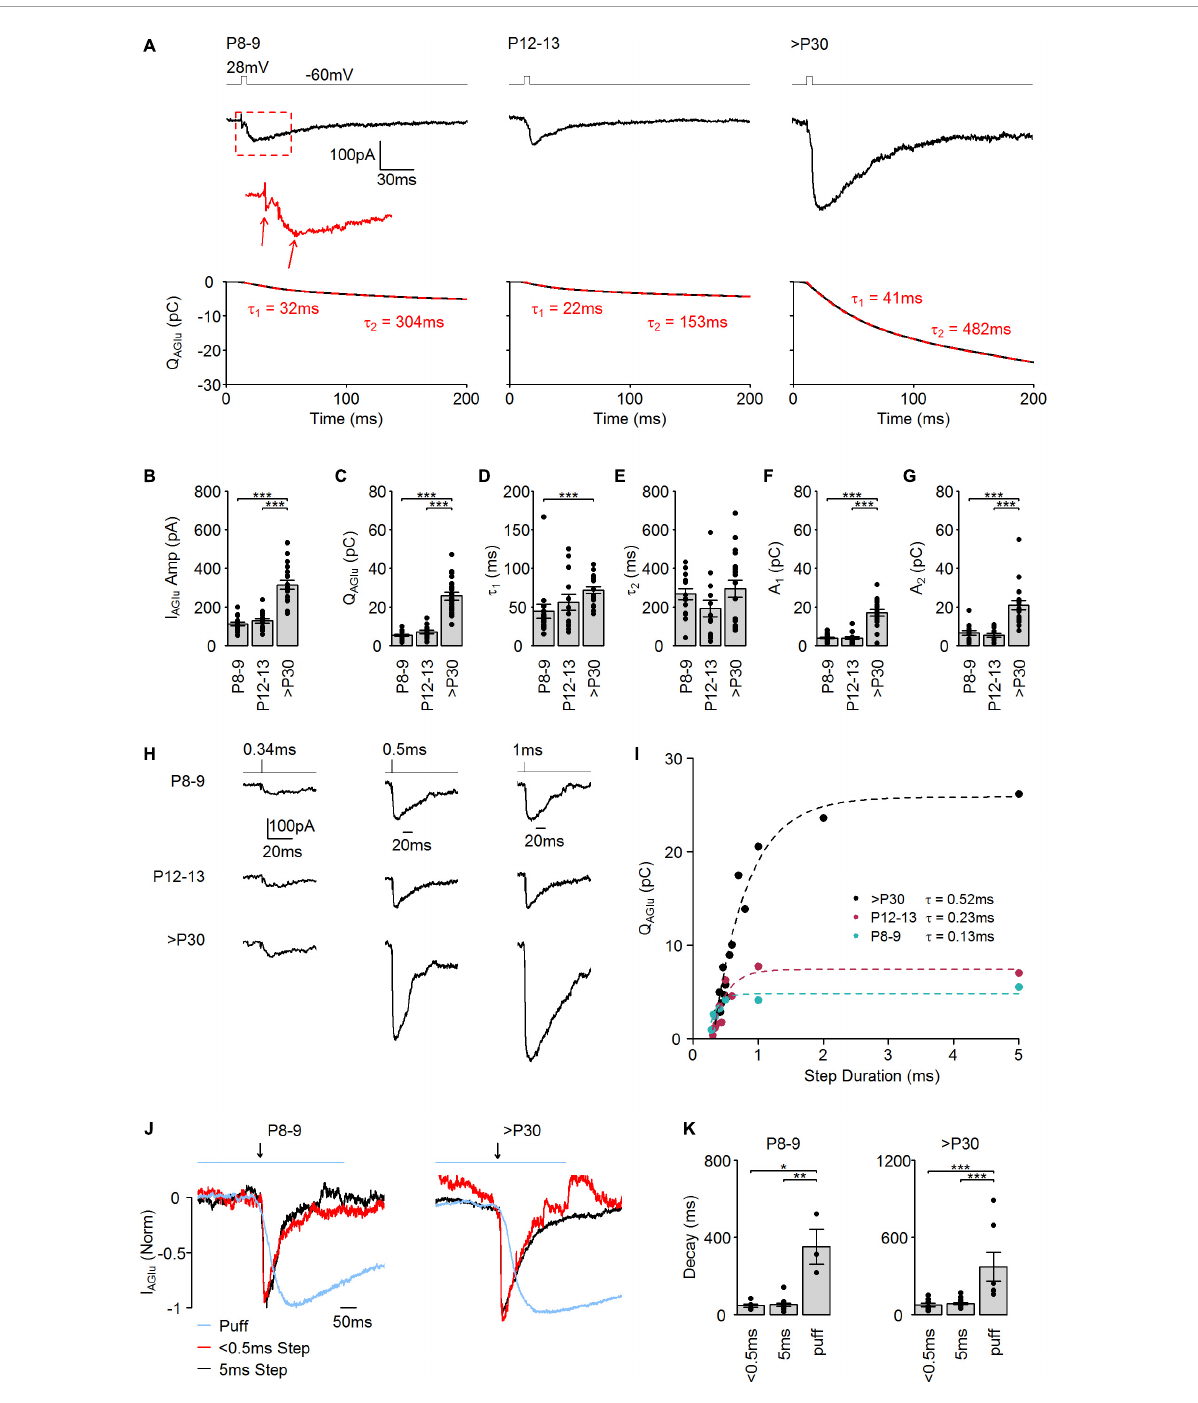
FIGURE1 Evoked SV release in developing cone photoreceptors. (A) Upper panel: Representative evoked I AGu events in response to a step depolarization (–60 to 28 mV, 5 ms) at the different developmental stages. Bottom panel: Black lines indicate the corresponding integral of the I AGlu events. Dashed red lines indicate a double exponential fit to the integral. (B) Amplitude of evoked I AGlu events ( p < 0.001, n = 15–19 cells, one-way ANOVA test). Post hoc Tukey Test (P8–9 vs. P12–13: p = 0.821, P8–9 vs. > P30: p < 0.001, P12–13 vs. > P30: p < 0.001). (C) Charge transfer of evoked I AGlu events ( p < 0.001, n = 15–19 cells, Kruskal-Wallis test). Post hoc Mann–Whitney U -test (P8–9 vs. P12–13: p = 0.230, P8–9 vs. > P30: p < 0.001, P12–13 vs. > P30: p < 0.001). (D) Time constant ( τ 1 ) of the first release component ( p = 0.001, n = 13–19 cells, Kruskal-Wallis test). Post hoc Mann–Whitney U -test (P8–9 vs. P12–13: p = 0.618, P8–9 vs. > P30: p < 0.001, P12–13 vs. > P30: p = 0.097). (E) Time constant ( τ 2 ) of the second release component ( p = 0.156, n = 13–19 cells, Kruskal-Wallis test). (F) Amplitude of the first